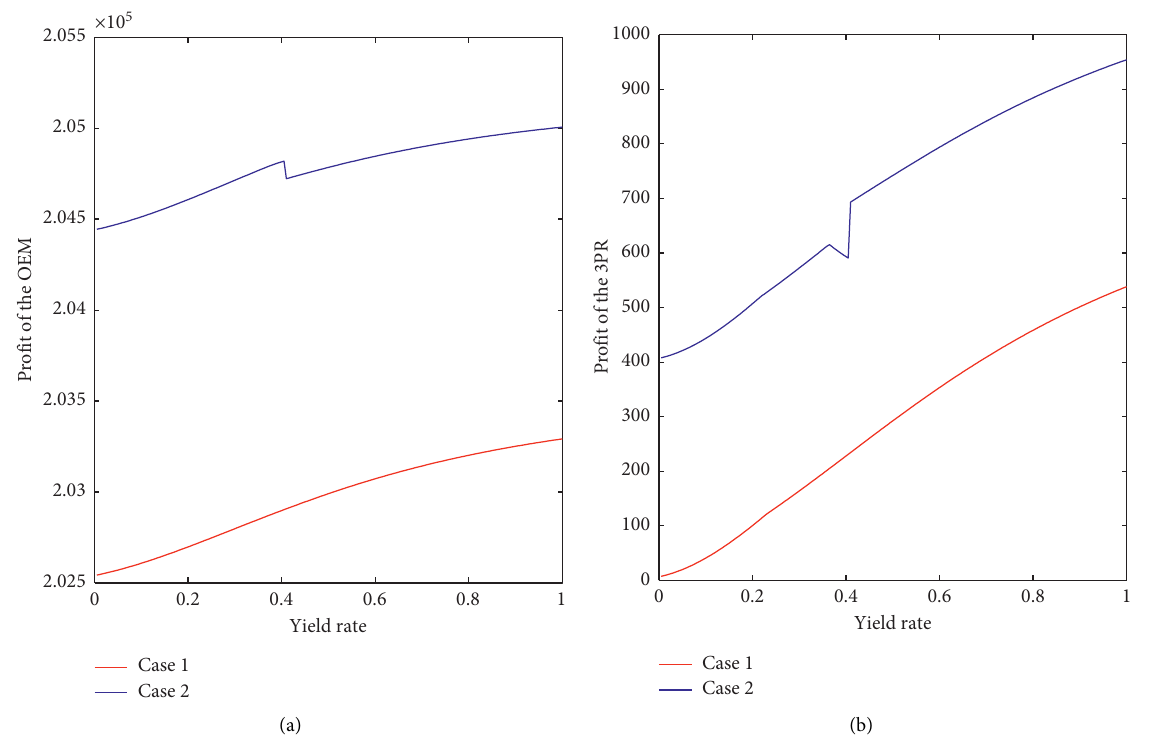
Figure 5: Profit of (a) the OEM and (b) the TPR vs. yield